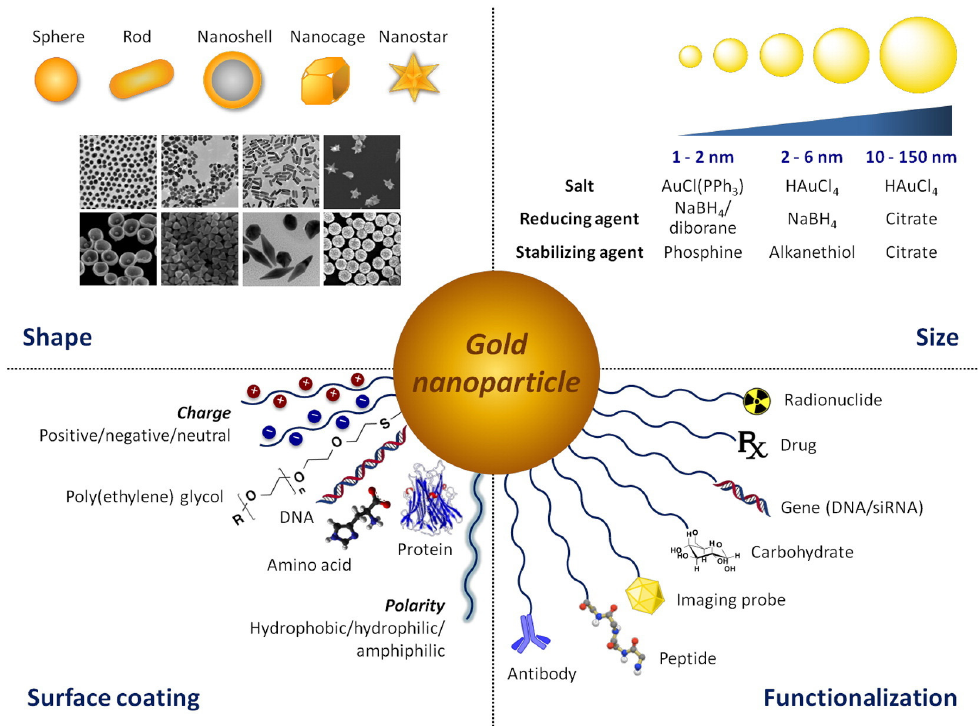
Figure 2. Physicochemical properties of gold nanoparticles explored in biological applications. Un- der illumination at or near the plasmon bands, gold nanoparticles absorb and scatter light, produce local electric fields, and can generate heat. These properties enable gold nanoparticles to be applied in bioimaging, surface-enhanced spectroscopies for sensing and molecular diagnostics, and photo- thermal therapy to destroy nearby cells. Due to their easy surface functionalization, gold nanopar- ticles are also explored for gene and drug delivery (reproduced with permission from Murphy et al., ref. [33]. Copyright 2019, American Chemical Society).